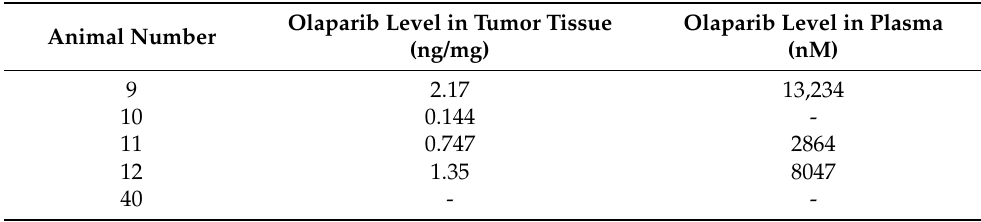
Table 1. Olaparib levels in tumor and plasma of vehicle/olaparib animals. Animals 9–12 received an oral dose of 100 mg/kg olaparib approximately 2 h before sacrifice. Animal 40 was sacrificed 7 days after the final olaparib administration. ’-‘ indicates values under detection limit. Olaparib Level in Tumor Animal Number